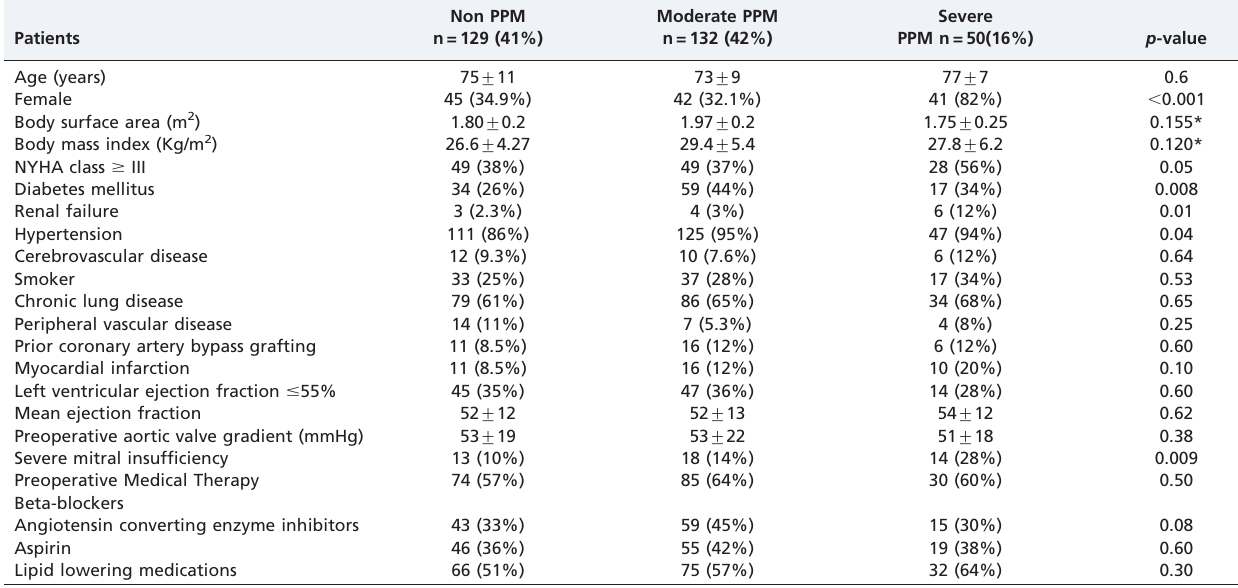
Table 1 - Preoperative